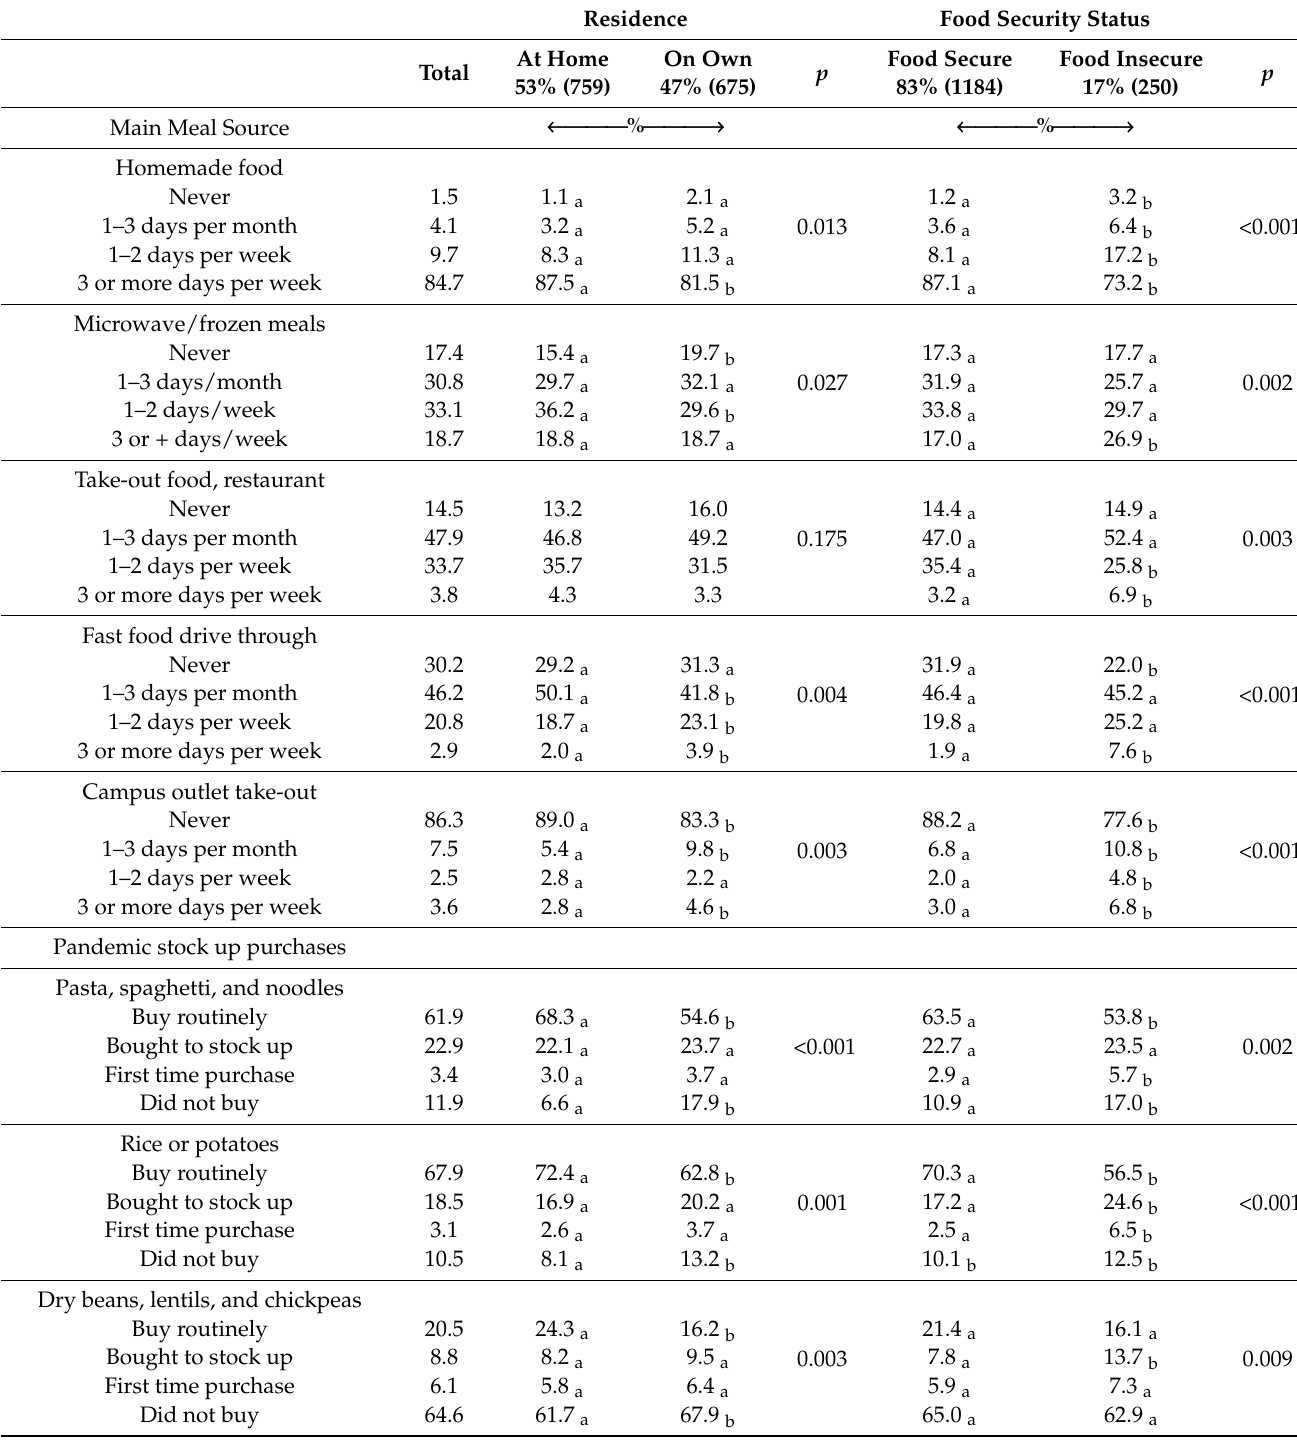
Table 1. Demographic characteristics of Midwestern university students by residence and food security status post-COVID-19 campus shift to online instruction (%; n = 1434).